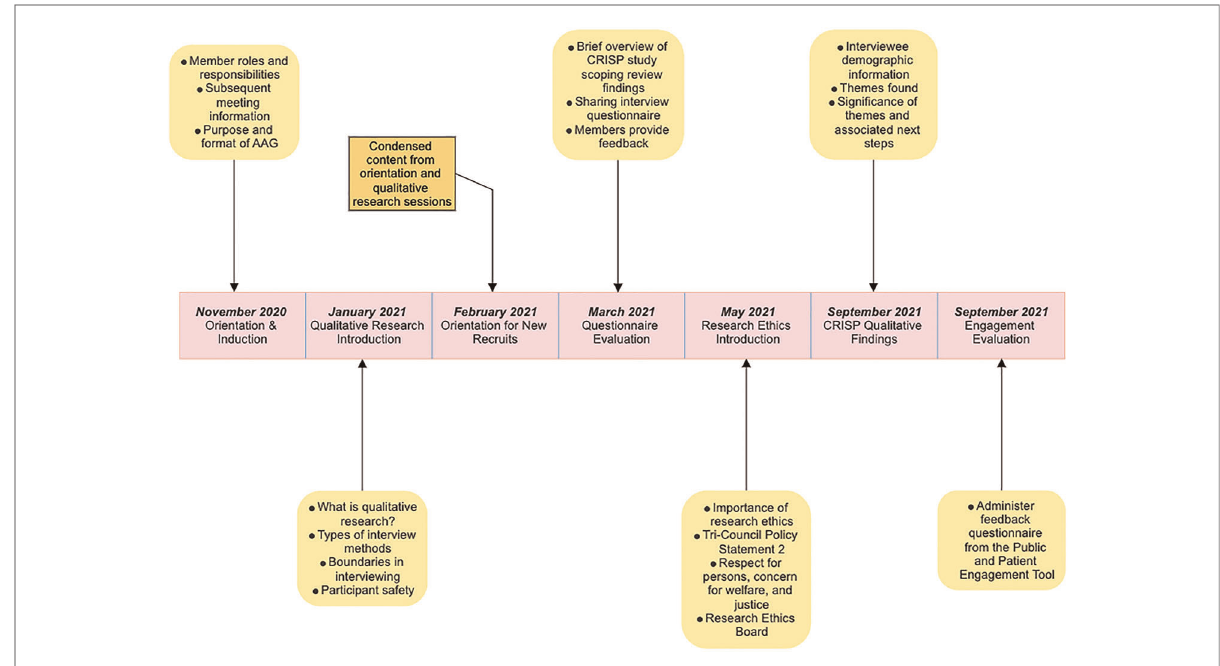
FIGURE 1 Outline of meetings and training sessions delivered to the AAG.